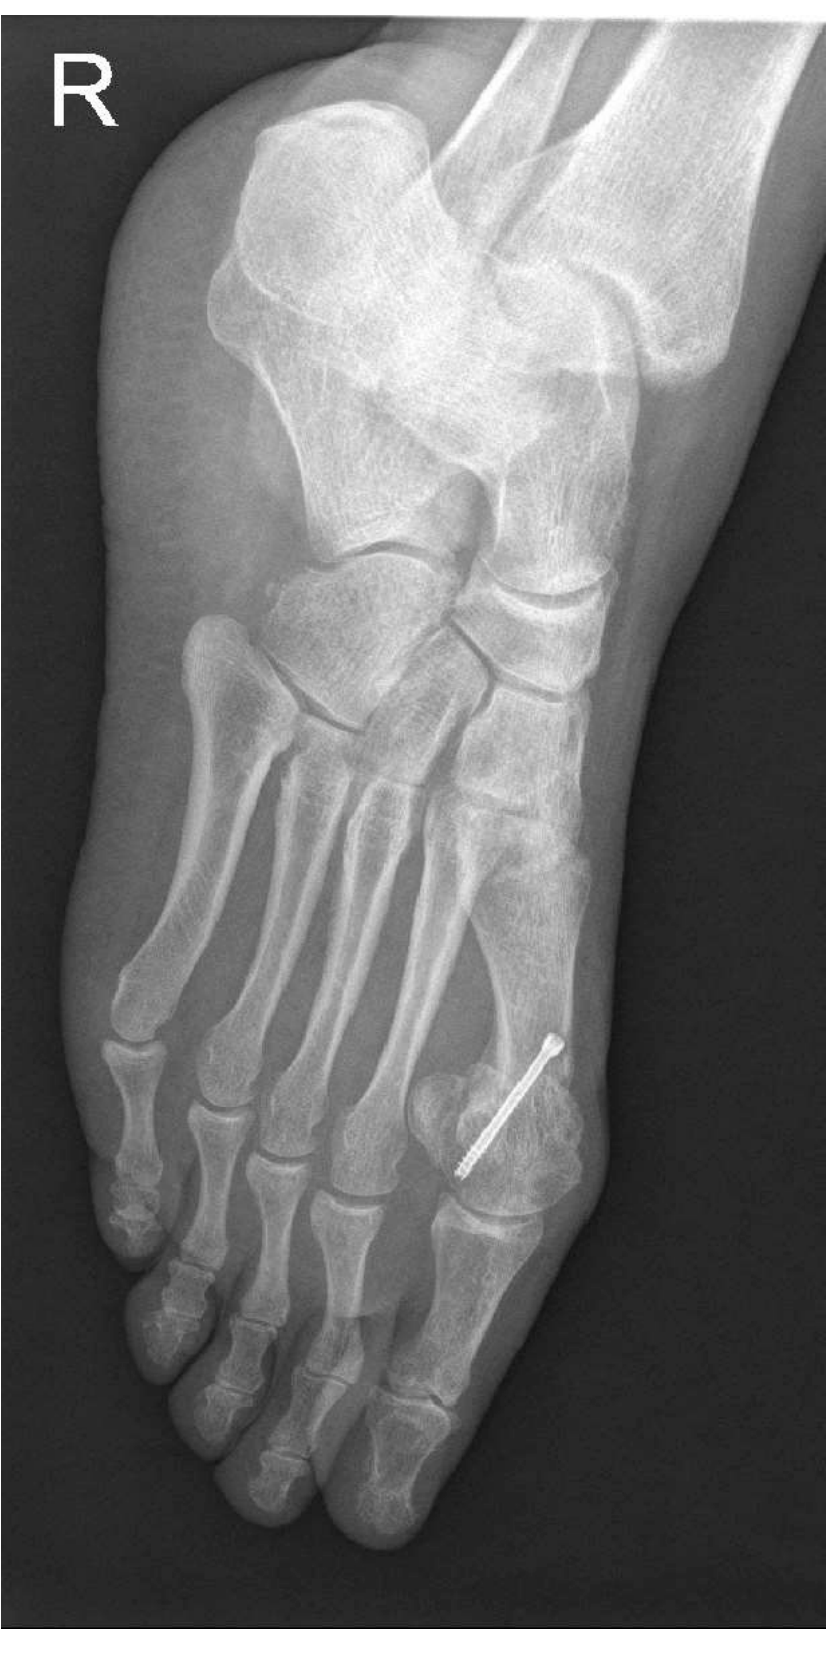
Figure 4. Postoperative oblique image after 12